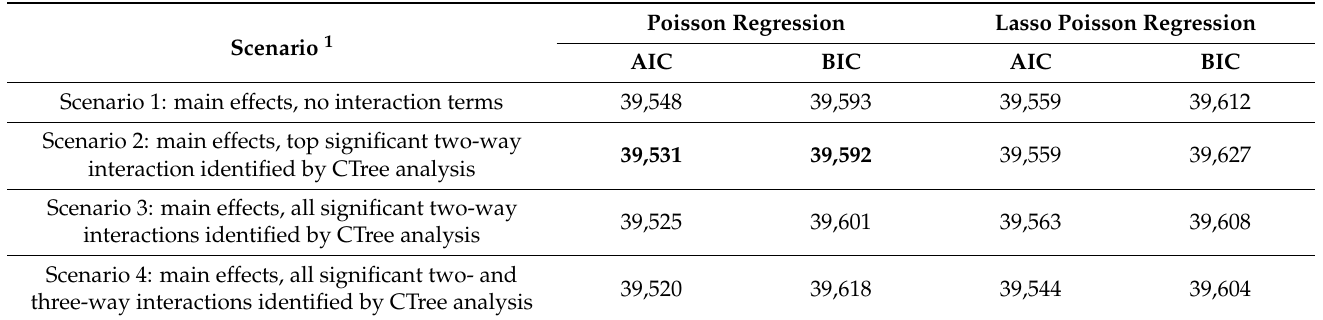
Table 2. GLM scenario